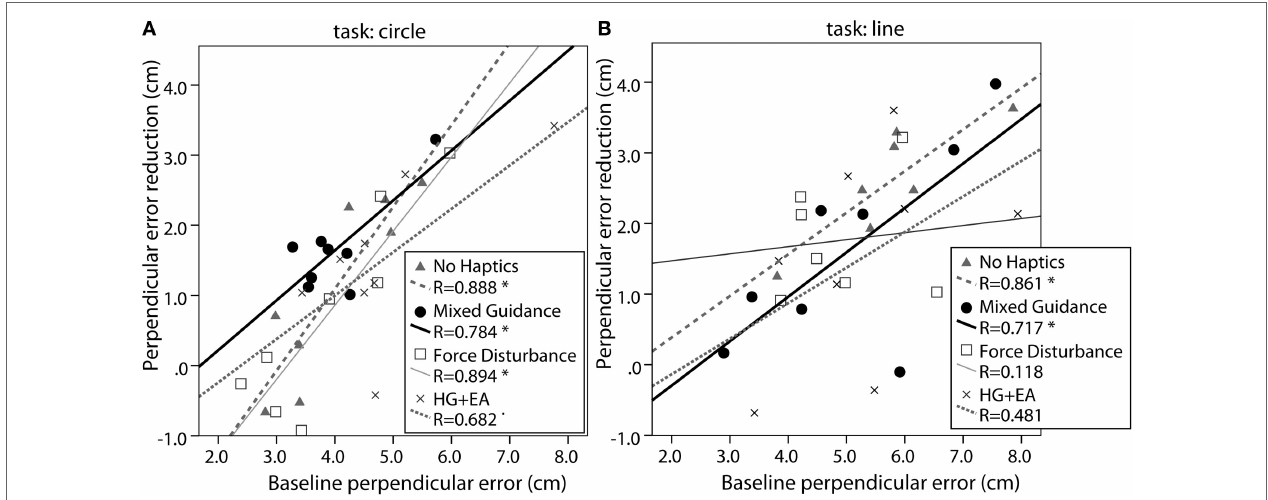
FIGURE 9 | Effect of initial skill level (baseline perpendicular error) on the perpendicular error reduction from baseline to short-term retention after training with the different training strategies for the circle task (A) and line task (B) . * p < 0.05, (cid:1) p < 0.1.